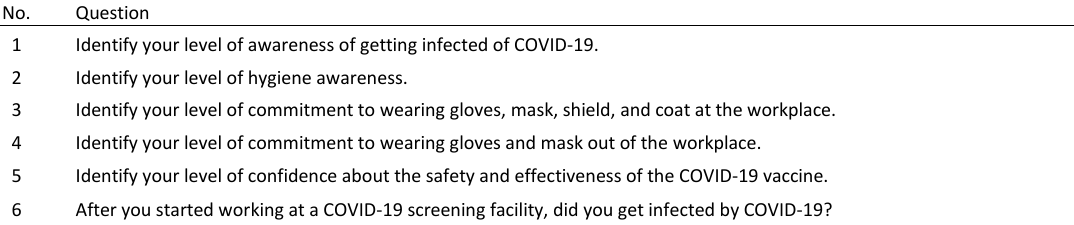
Table 1 : COVID-19 awareness and knowledge among healthcare workers